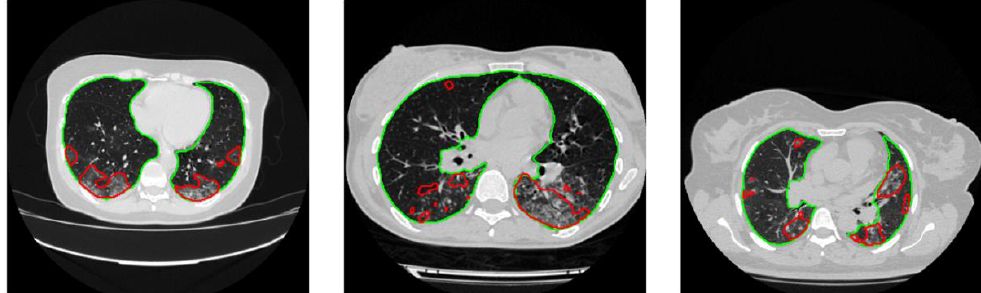
Figure 7. Detection of lung and lesion for external validation (Lung segmentation: green, infection: red).